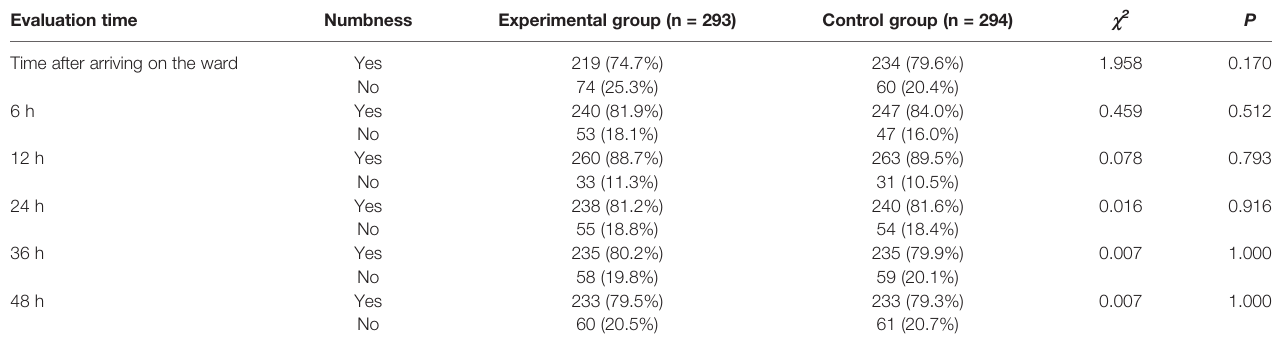
TABLE 6 | Comparison of subjective symptom of numbness between the two groups (n%).